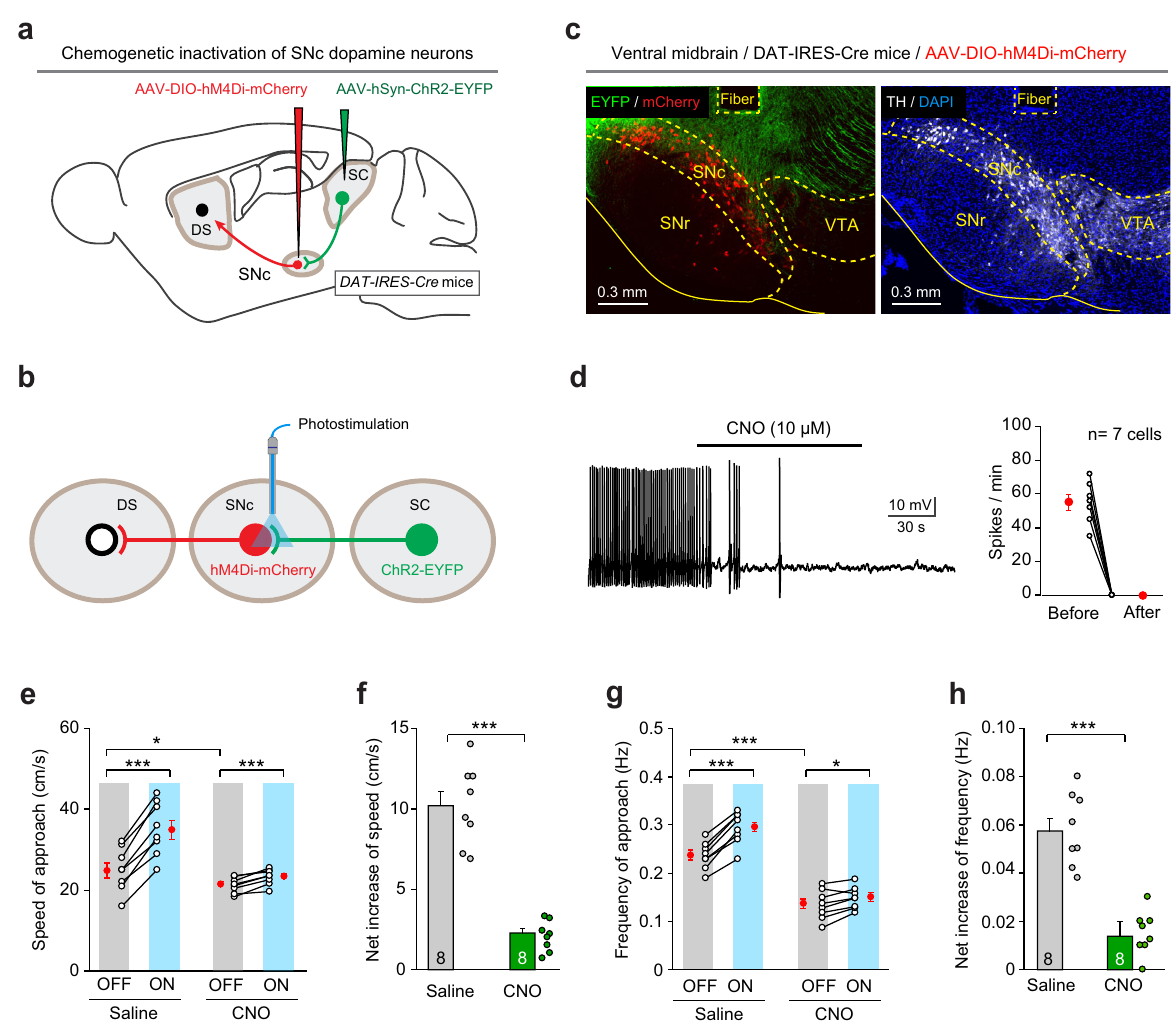
Fig. 8 SC – SNc pathway promotes appetitive locomotion via SNc dopamine neurons. a Schematic diagram showing injection of AAV-DIO-hM4Di- mCherry and AAV-ChR2-EYFP into the SNc and SC of DAT-IRES-Cre mice. b Schematic diagram showing implantation of an optical fi ber above the SNc to apply light stimulation on ChR2-EYFP + axon terminals from the SC. c An example coronal section of ventral midbrain showing the optical fi ber track above the hM4Di-mCherry + SNc dopamine neurons intermingled with ChR2-EYFP + axons from the SC (left). The boundaries of SNc and VTA were delineated by the immuno fl uorescence of TH (right). This experiment was repeated independently in eight mice with similar results. d An example train of action potentials recorded from SNc dopamine neurons expressing hM4Di-mCherry (left) and quantitative analyses of spike number per minute before and 3 min after perfusion of CNO (10 μ M) in ACSF (right). e The effect of light stimulation of the SC – SNc pathway on speed of approach during predatory hunting in mice without (Saline) and with (CNO) chemogenetic suppression of SNc dopamine neurons. f Chemogenetic suppression of SNc dopamine neurons with CNO signi fi cantly attenuated the net effect of SC – SNc pathway activation on the speed of approach. g The effect of light stimulation of the SC – SNc pathway on frequency of approach during predatory hunting in mice without (Saline) and with (CNO) chemogenetic suppression of SNc dopamine neurons. h Chemogenetic suppression of SNc dopamine neurons with CNO signi fi cantly attenuated the net effect of SC – SNc pathway activation on the frequency of approach. Number of cells ( d ) and mice ( e-h ) was indicated in the graphs. Data in d – h are means± SEM (error bars). Statistical analyses